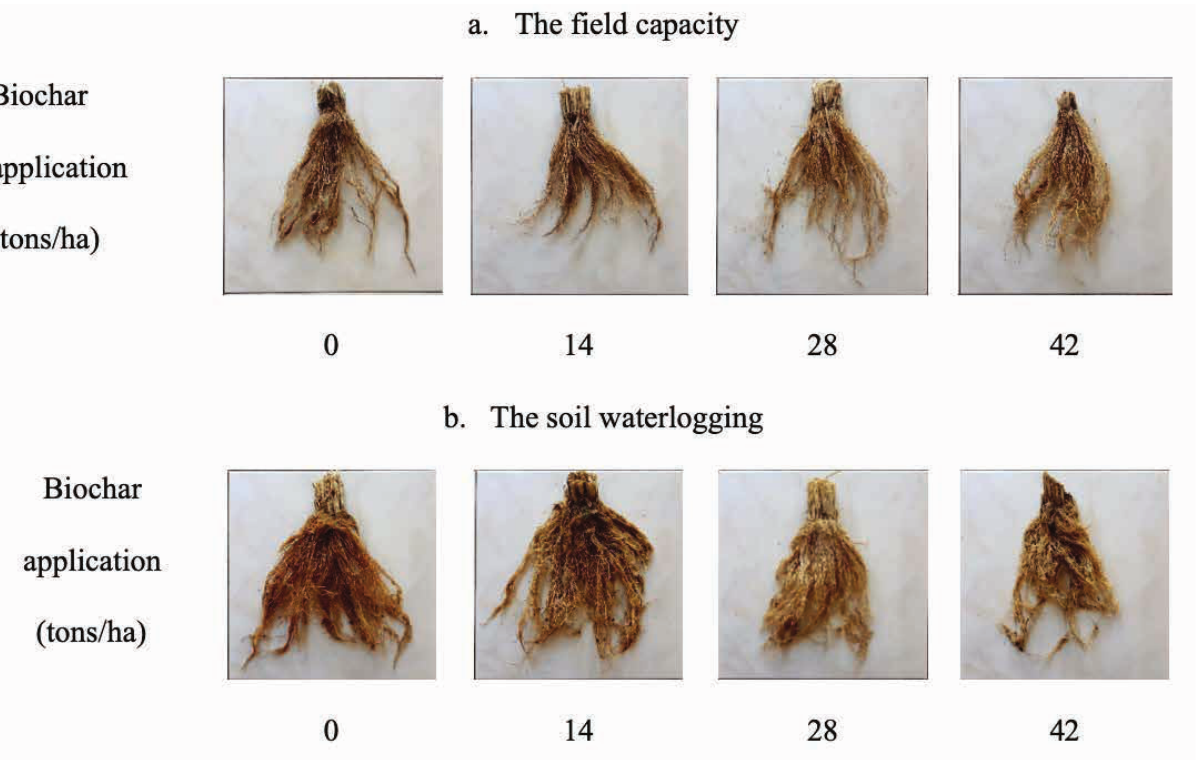
Figure 5: The Effect of Soil Water Content on the Root of Rice Performance in the four doses of biochar